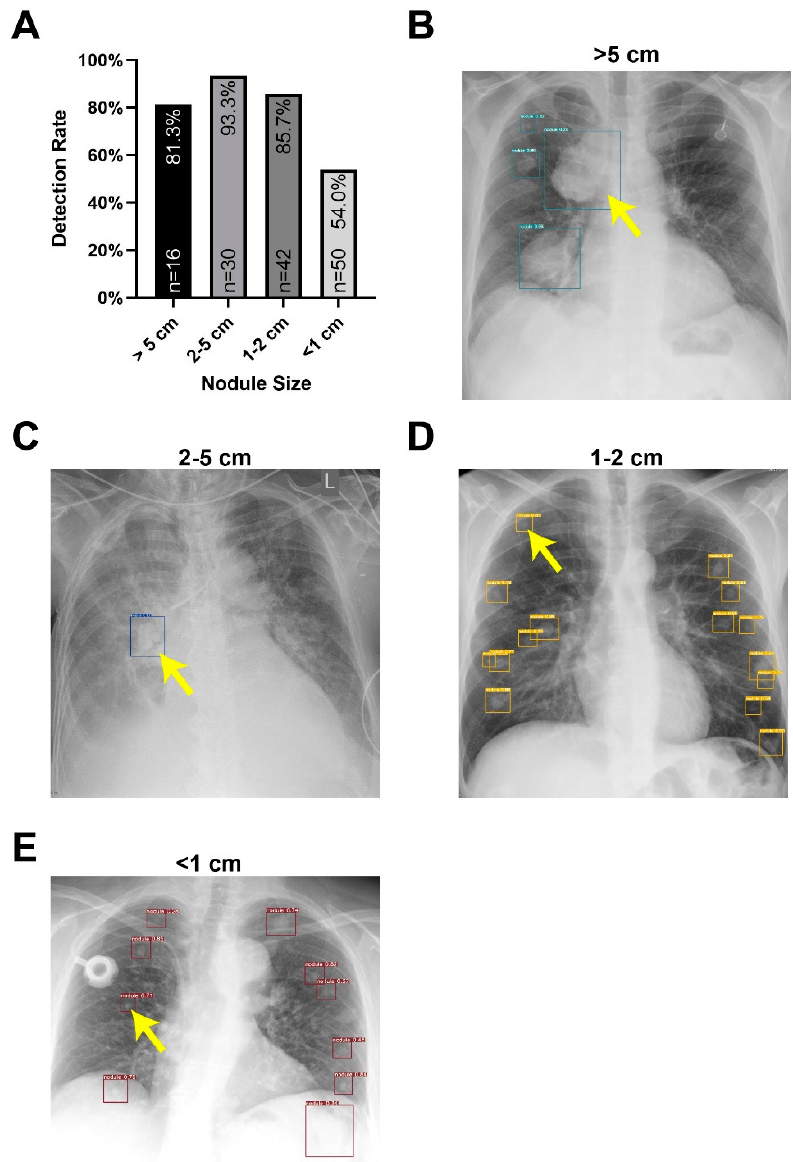
Figure 5. Smallest Reliably Detectable Size. ( A ) Findings in the CT were assigned to different groups according to size. Based on the X-ray, the algorithm was intended detect all findings. The sensitivity was divided into the groups according to the findings found and overlooked. While the program reliably detected nodules between 1 and 5 cm in over 93.3% and 85.7%, respectively, nodules larger than 5 cm and especially smaller than 1 cm were more challenging for the algorithm. ( B ) Lung X-ray of a finding over 5 cm. ( C ) Lung X-ray of a finding between 2–5 cm. ( D ) Lung X-ray of a finding between 1–2 cm. ( E ) Lung X-ray of a finding under 1 cm. Yellow arrows mark the